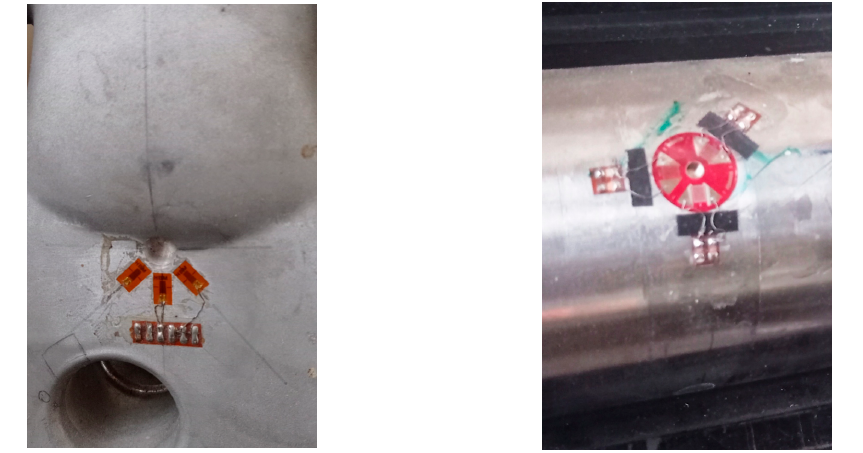
Figure 1. Illustration of internal stress evaluation by destructive hole-drilling tests (courtesy of CETIM, Senlis, France).